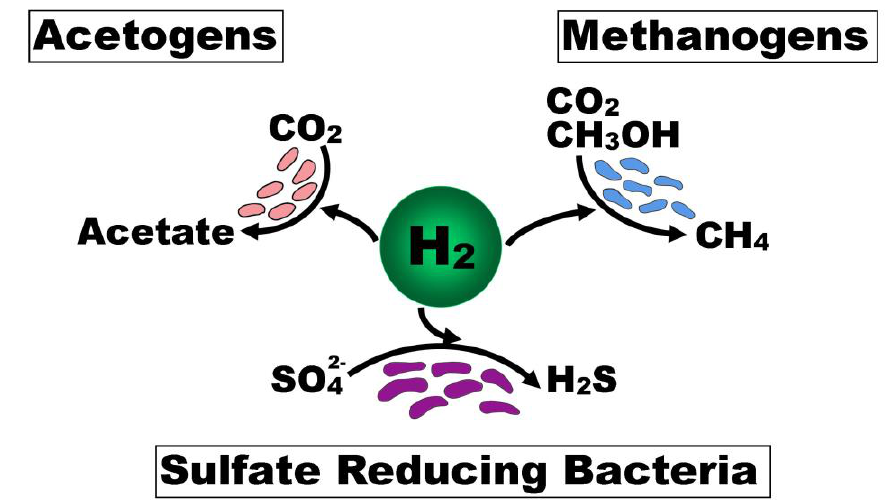
Figure 2. Bacterial competition for hydrogen for anaerobic respiration in the lumen of the intestine. Legend: Acetogens, methanogens, and sulfate reducing bacteria are the microbial groups that compete for H 2 in anaerobic respiration in the lumen of the colon. The availability of hydrogen can shape the composition and functional output of microbial communities.